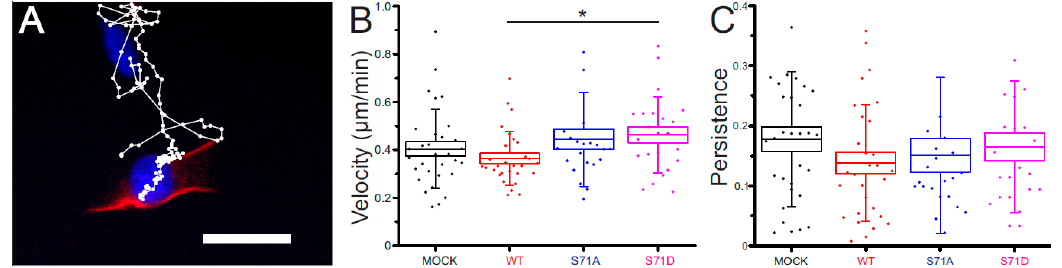
Figure 4. Migration characteristics. ( A ) Overlay of the last frame of a representative movie, with the trajectory of the cell during the movie. Scale bar; 50 µm; ( B ) quantification of the mean instantaneous velocity of cells under the different conditions, as indicated. * p < 0.05 (Student’s t -test); and ( C ) quantification of the persistence of cells for the trajectories represented in ( B ).